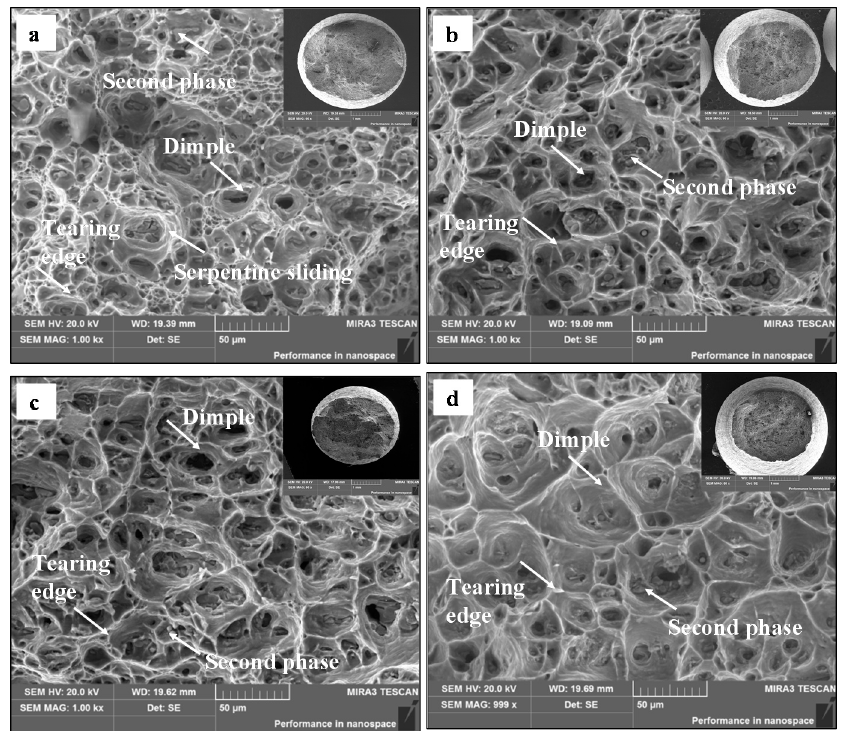
. ε = 0.003 s − 1 ; ( b ) T = 200 ◦ C, . ε = 0.0003 s − 1